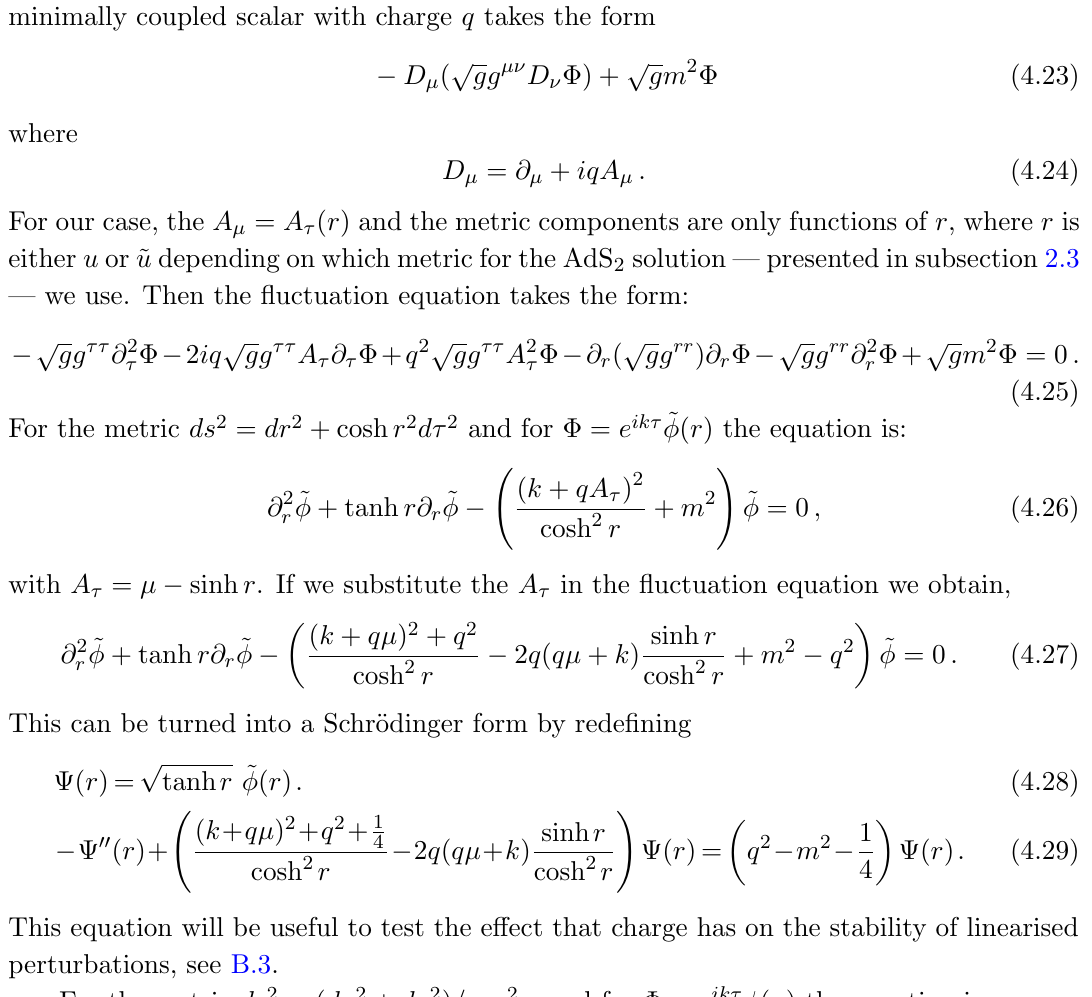
Figure 3 . The 1 (cid:0) 2 cross correlator for m = 1 maximises in the IR k = 0. It remains similar for relevant perturbations as well (the \bump" becomes